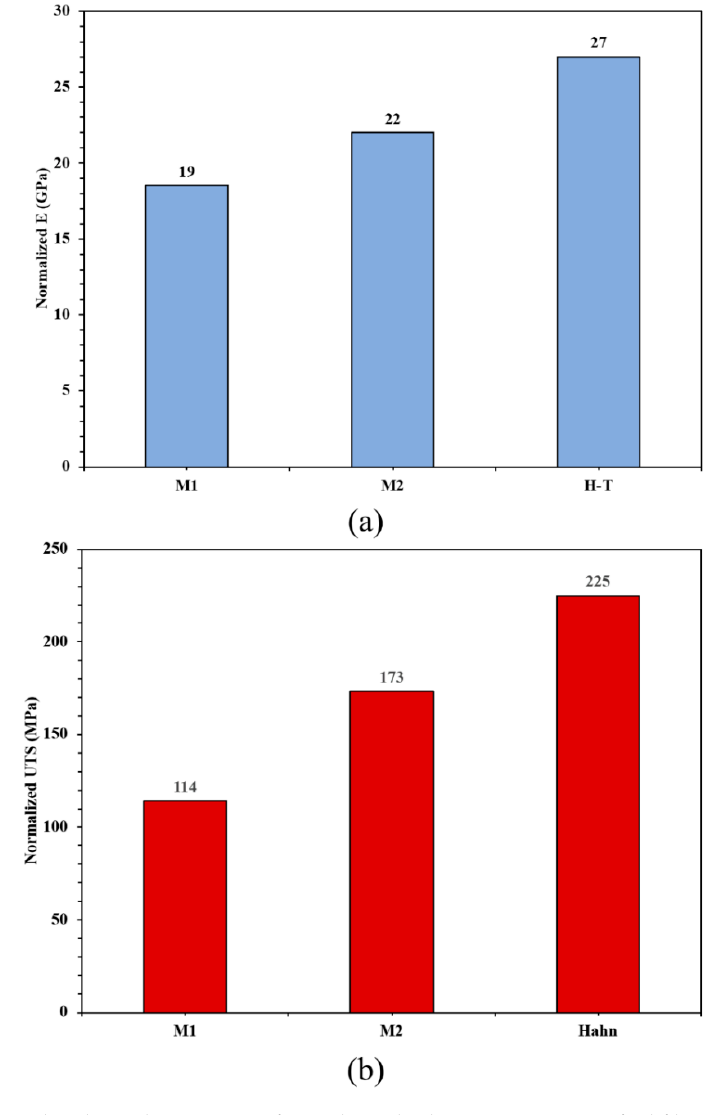
Figure 11. Normalized tensile properties for each method in respect to a unified fiber weight fraction of 33%. Method 2 shows significant improvement in performance over Method 1 both in; ( a ) Tensile modulus by 16%, and ( b ) Tensile strength by 52% .